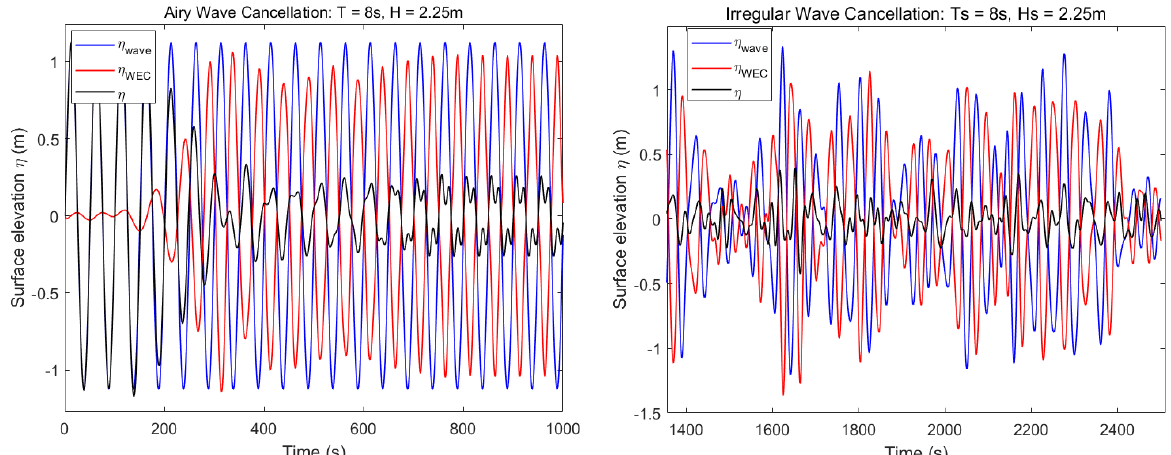
Fig. 11: Downstream surface elevations of an incoming wave, surface elevation generated by the CycWEC and total resulting surface elevation for regular wave cancellation (left) and irregular wave cancellation (right), as an